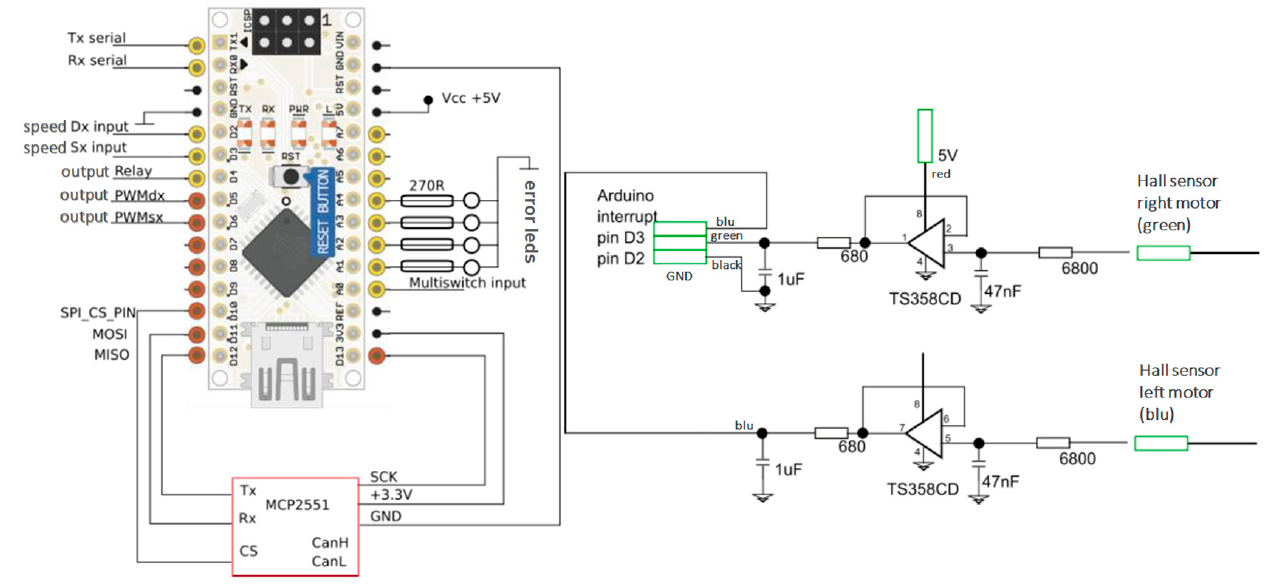
Figure 11. Electronic scheme of Arduino Nano CAN bus module connections ( on the left ) and speed input filtering circuit ( on the right ).